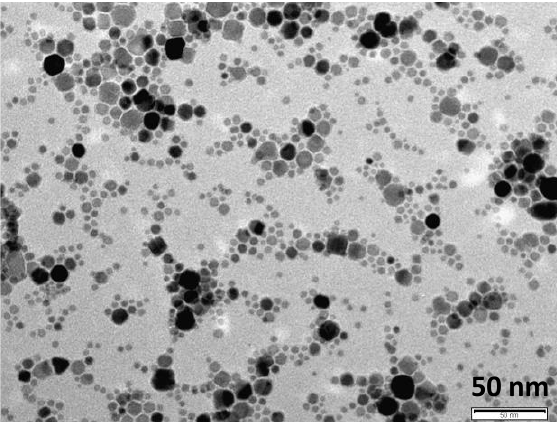
Figure 10. TEM images of magnetite NPs coated with oleic acid.